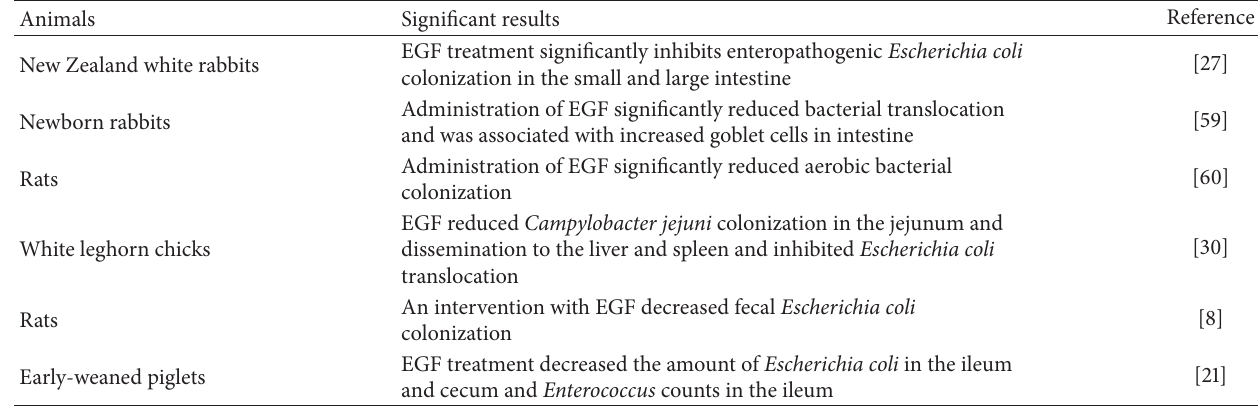
Figure 3: Mechanism of EGF induced mucins secretion. EGF treatment can increase the expression of interleukin-13 and keratinocyte growth factor (KGF) that resulted in an increased Muc2 expression [15]. EGF through inducing DUOX2 expression and ROS production to activate ERK1/2-PKC pathways thus inducing Muc5AC and Muc3 expression [42].